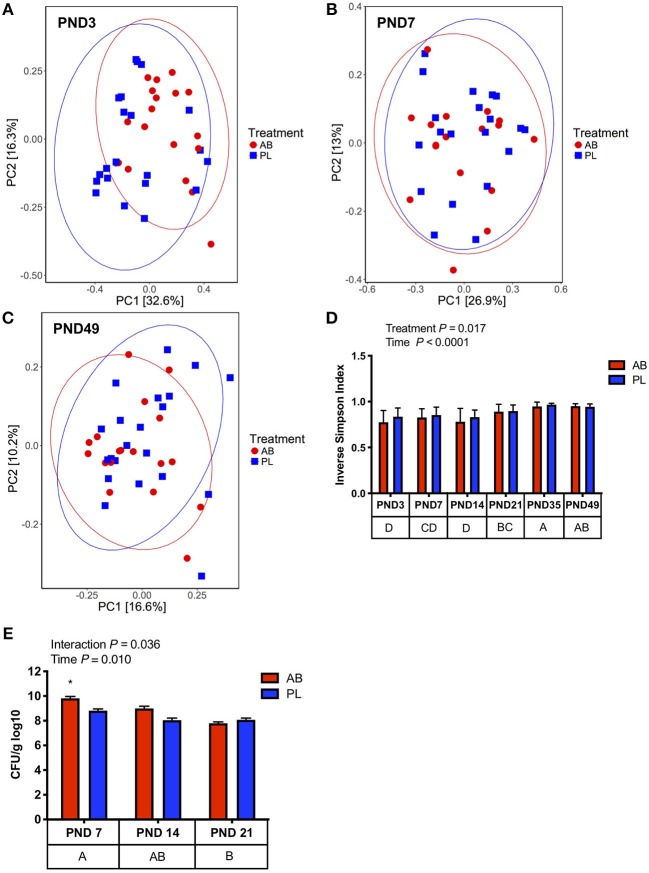
Pigs treated with antibiotics (AB) from day 0–14 had transient changes in microbial community composition compared to those treated with placebo (PL), as determined with Bray-Curtis dissimilarity. (A) On PND 3 there is distinct clustering of pigs treated with AB vs. PL (Adonis, P = 0.025); AB n = 20, PL n = 21; (B) On PND 7 no distinct clustering was observed between pigs treated with AB and PL (Adonis, P = 0.693); AB n = 17, PL n = 20. (C) On PND 49 pigs treated with AB and PL were not distinctly clustered (Adonis, P = 1.0) (D) Alpha diversity was reduced in AB treated pigs and significantly increased overtime (Two-way ANOVA, Treatment P = 0.017; Time P < 0.0001; Interaction P = 0.444). PND 14: AB n = 18, PL n = 21; PND 21: AB n = 18, PL n = 21; PND 35: AB n = 20, PL n = 21; PND 49: AB n = 18, PL n = 21. (E) There was a significant interaction between Treatment and Day on cecal coliform counts. Pigs treated with AB on PND 7 had higher coliform counts vs. PL on PND 7, 14, and 21 and AB on PND 14 and 21 as indicated by an asterisk (Two-way ANOVA; Treatment P = 0.0257; Day P = 0.0103; Interaction P = 0.0358, post-hoc pair-wise comparisons made with Bonferroni correction), PND 7: AB n = 6, PL n = 6; PND 14: AB n = 8, PL n = 6; PND 21: AB n = 5, PL n = 5. The main effect of time is displayed below each figure and those PND not sharing a common letter differ significantly.